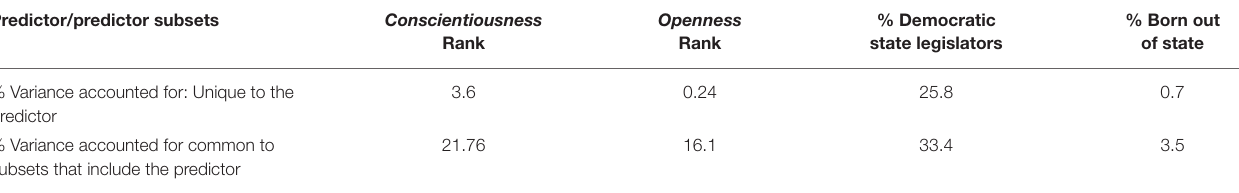
TABLE 4A | Commonality regression analysis of the stringency rank of state Covid-19 restrictions.